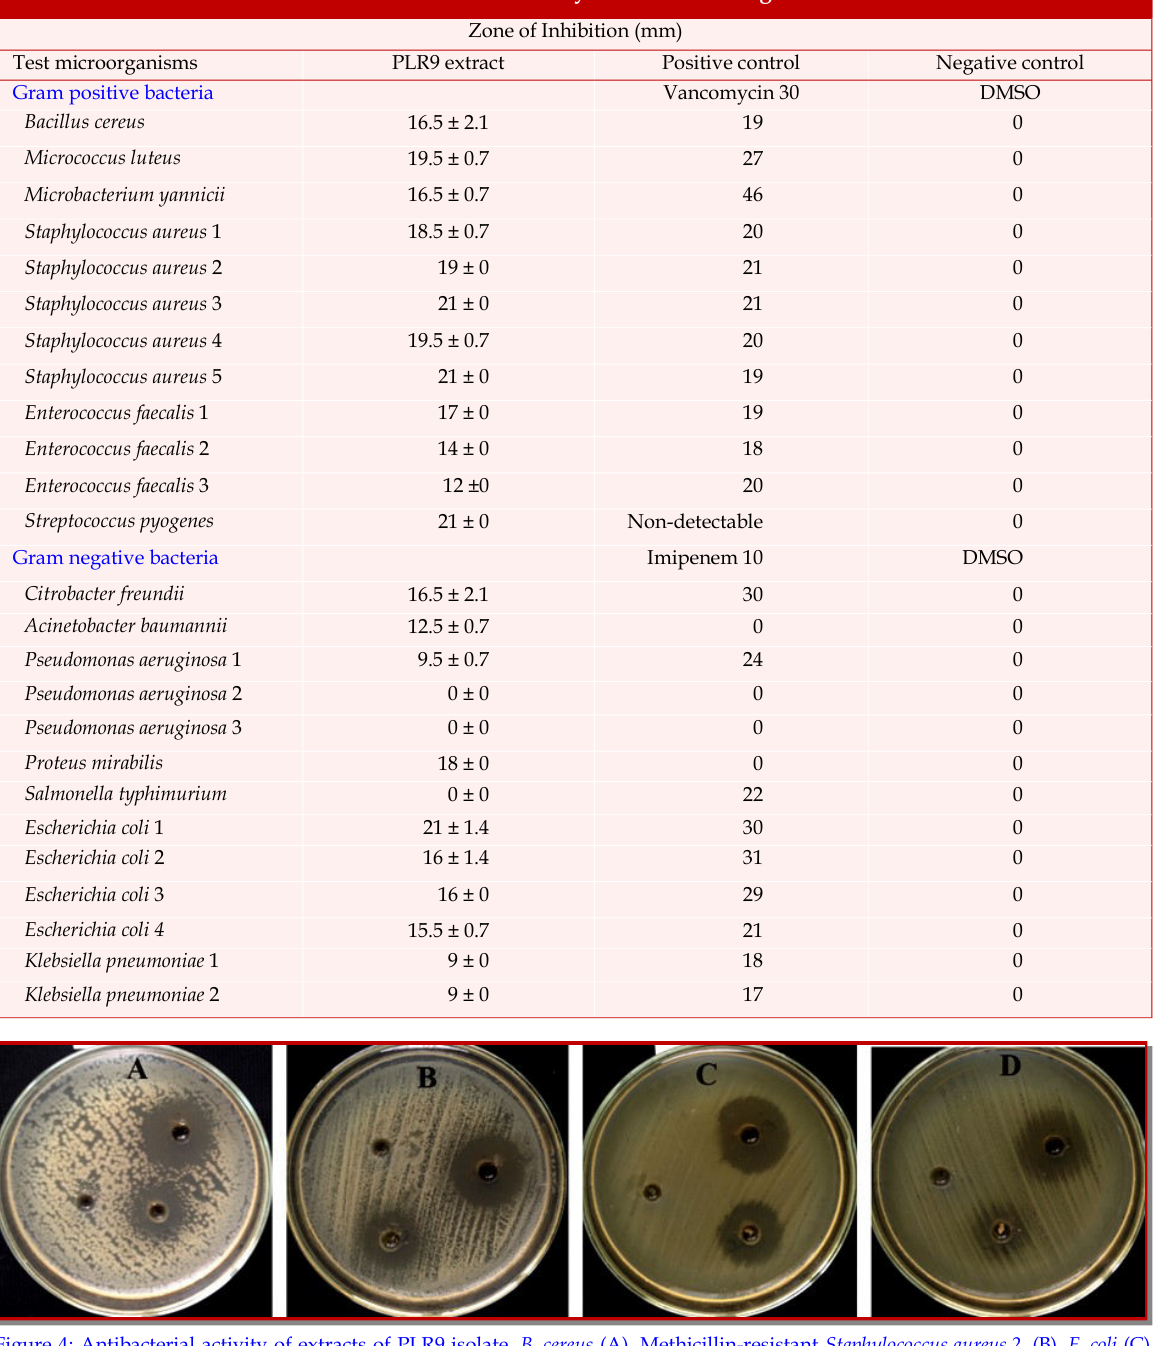
Figure 4: Antibacterial activity of extracts of PLR9 isolate, B. cereus (A), Methicillin-resistant Staphylococcus aureus 2 (B), E. coli (C) and C. freundii